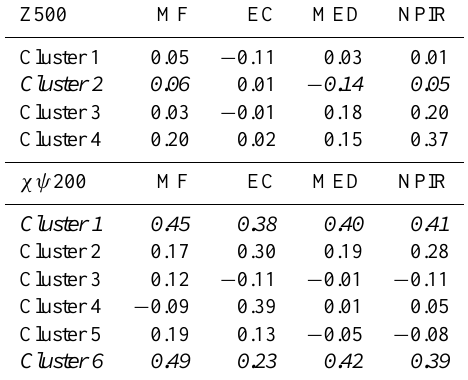
Table 1. Correlation of frequency of